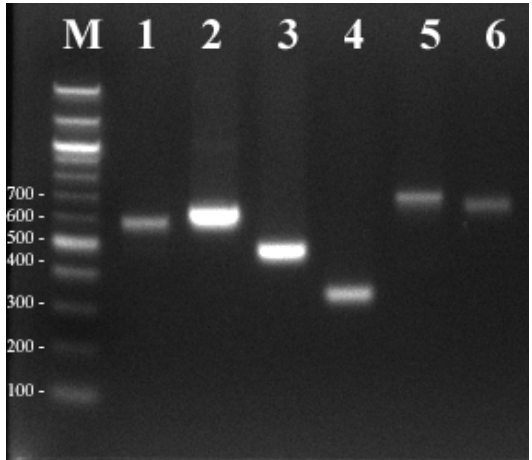
Figure 4. PCR verification of trnM-argB InDel markers for six Pyropia species. M, 1 kb DNA ladder; 1, P. yezoensis ; 2, P. dentata ; 3, P. suborbiculata ; 4, P. haitanensis ; 5, P. seriata ; 6, P. pseudolinearis.